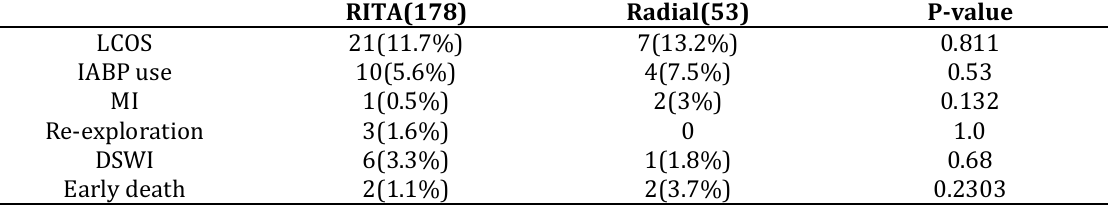
Table 3. Early postoperative results between RITA and RA